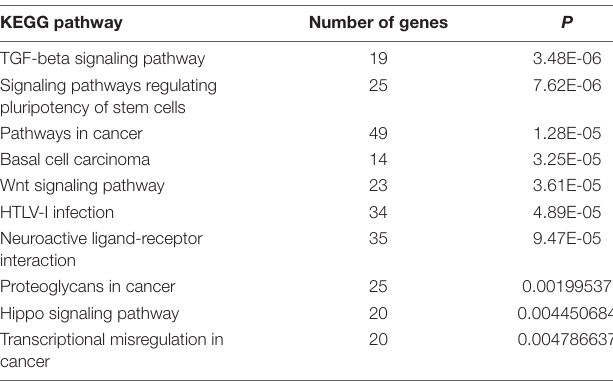
TABLE 4 | Top 10 significantly enriched Gene Ontology (GO) terms of target genes of differentially expressed long non-coding RNAs (DElncRNAs).